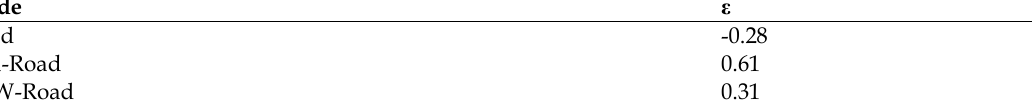
Elasticity for the three modes model (-5% of trucking costs) Mode ε Road -0.28 Rail-Road 0.61 IWW-Road